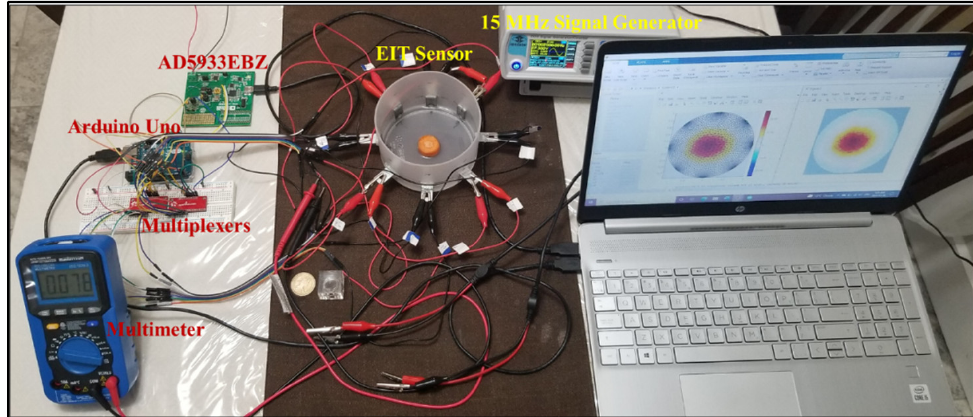
Figure 5. An EIT experimental setup for image reconstruction of the inhomogeneities. The data were stored by the measurements using EIS tool and DDS signal generator. For example, a carrot slice was placed at the centre of the domain and that was reconstructed using EIDORS.